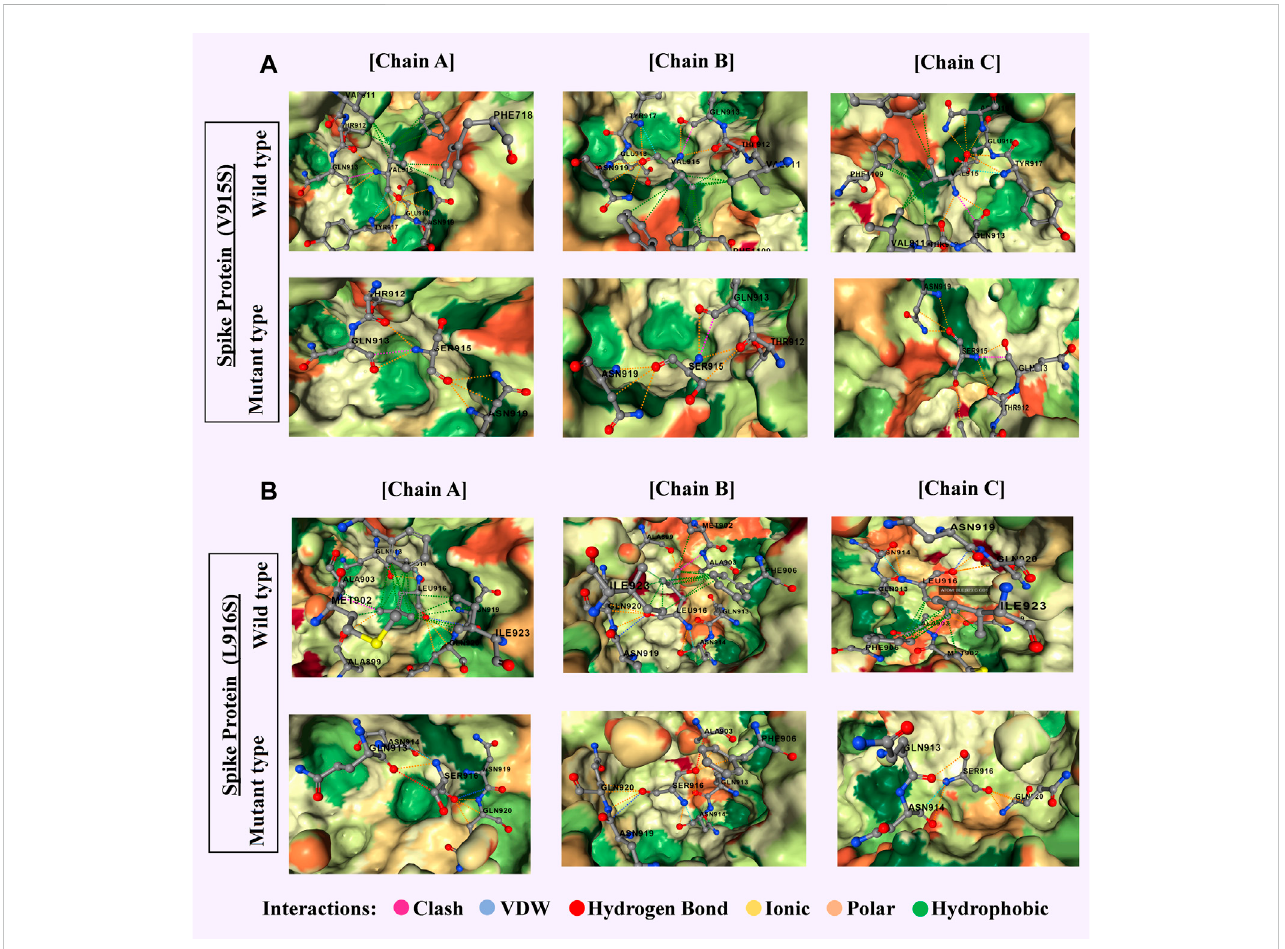
FIGURE 7 Most signi fi cant two mutations of spike proteins of delta variant with a comparative overview of molecular interaction (A) V915S-chain A-absence of 9hydrophobicbonds,2polarbonds,and1VanderWaalsbondinthemutein.ChainB-theabsenceof9hydrophobicbonds,1polarbond,and1VanderWaals bond in the mutein. Chain C- absence of 9 hydrophobic bonds, 1 polar bond, and 1 Vander Waals bond in the mutein. (B) L916S-chain A-the absence of 12hydrophobicbondsinthemutein.ChainB-absenceof17hydrophobicbonds,increaseof3polarbondsand1hydrogenbond,decreaseofclashinthe mutein. Chain C- the absence of around 10 hydrophobic bonds, 1 carbonyl bond, and 1 clash in the mutein. Clashes are de fi ned as unfavorable interactions where atoms are too close